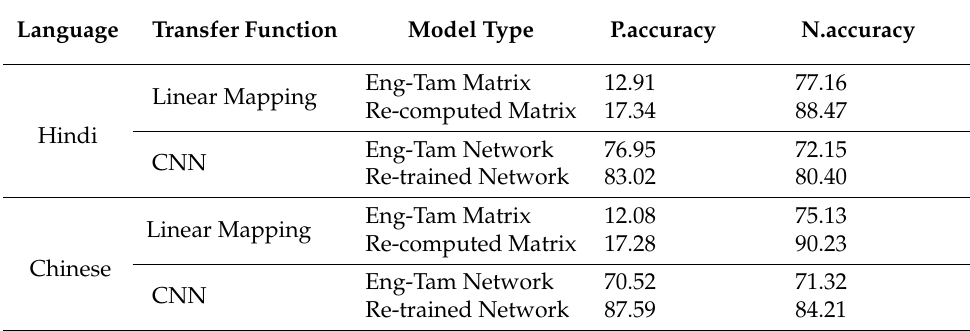
Table 4. Neighbourhood and Pairwise Accuracy (N.accuracy and P.accuracy) of Asian TFGE Embed- dings trained by various